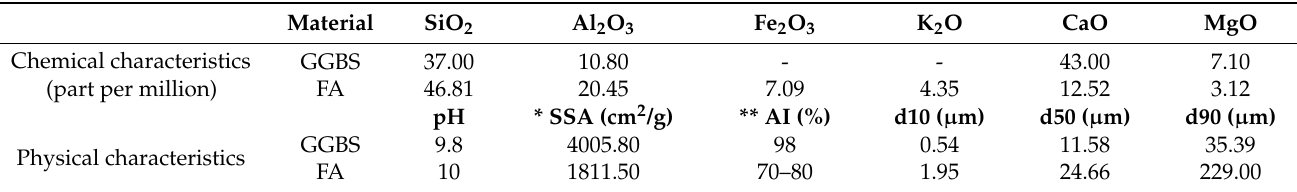
Table 2. Physio-chemical characterization of the materials.